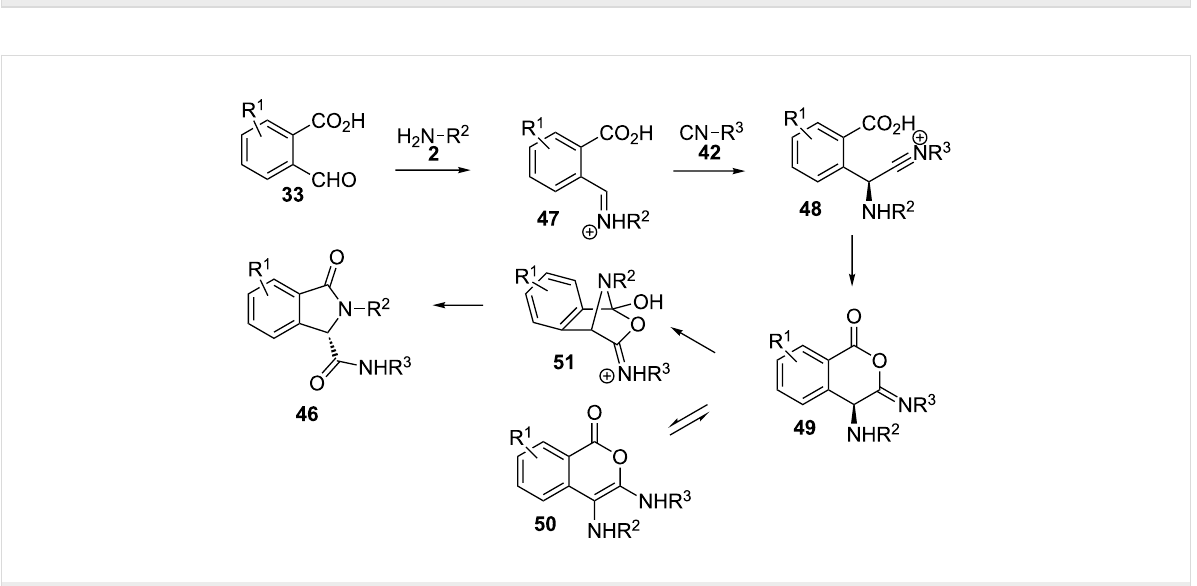
Scheme 14: Proposed mechanism for the enantioselective formation of isoindolinones 46